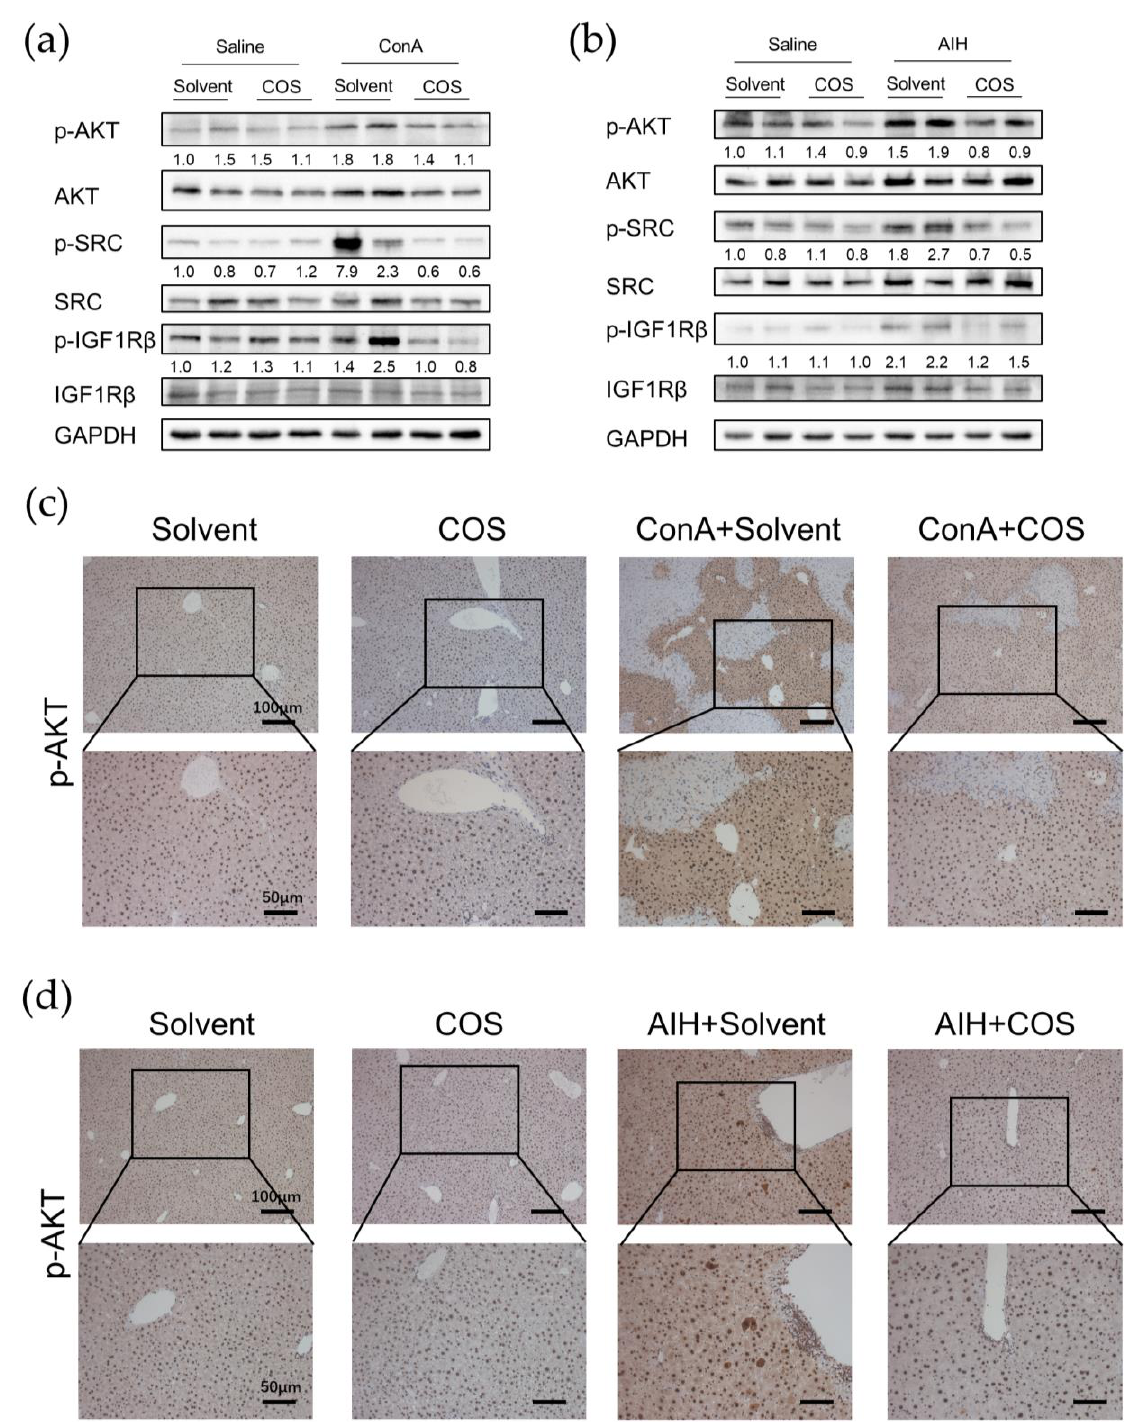
Figure 10. Costunolide inhibited the phosphorylation of AKT, SRC, and IGF1R. ( a ) Protein expression in ConA-induced acute hepatitis. Two samples from two different mice in each group are presented. The numbers indicate the ratio of pAKT/AKT, pSRC/SRC, and pIGF1R β /IGF1R β , respectively. ( b ) Protein expression in chronic murine autoimmune hepatitis. ( c ) Immunohistochemistry of phospho-AKT in ConA-induced acute hepatitis. ( d ) Immunohistochemistry of phospho-AKT in chronic murine autoimmune